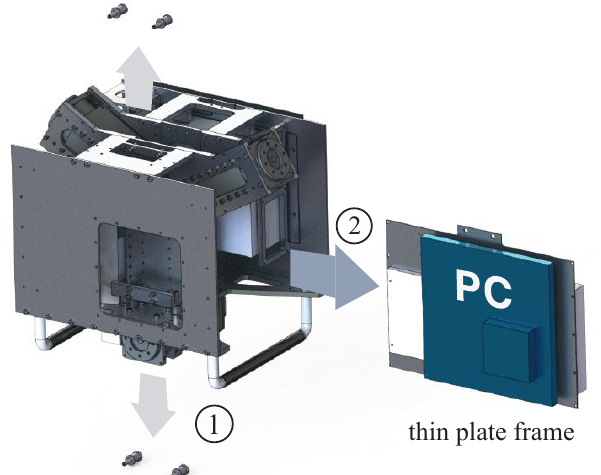
Figure 7. Exploded view of computer module. The modularized computer board can be sideways- disassembled by removing four bolts.